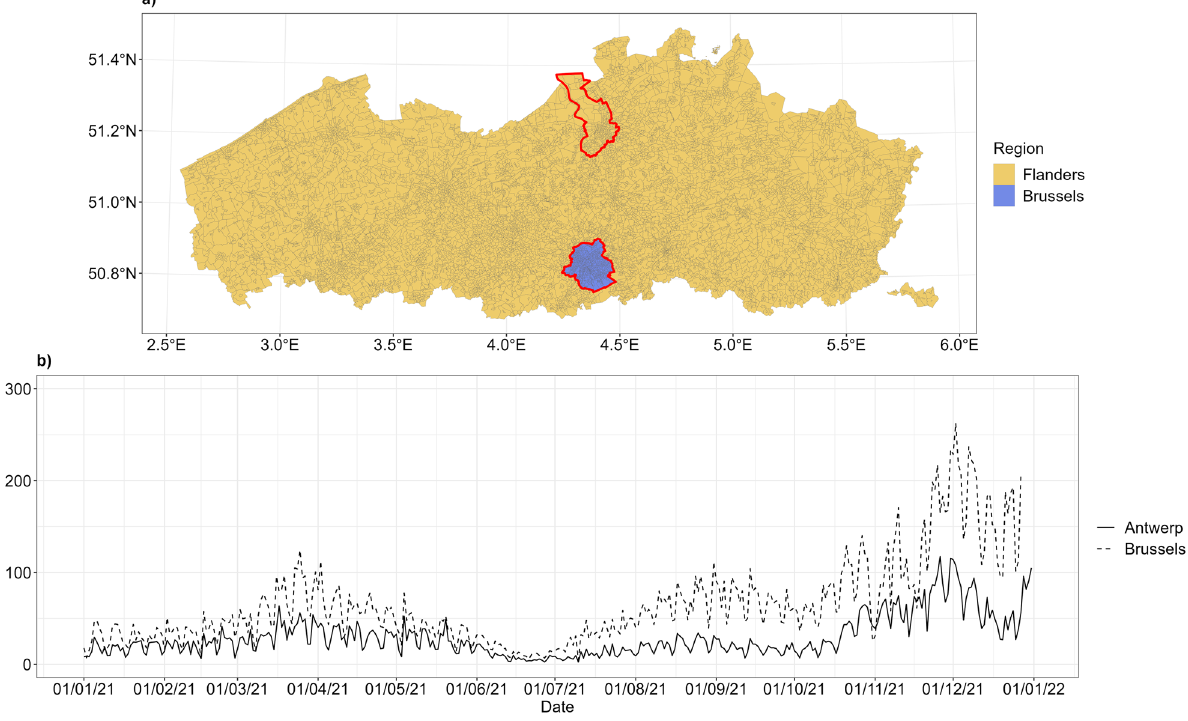
Figure 1. Statistical sectors in Flanders and Brussels Region. The location of selected study areas is marked by red line in a). Daily incidence rates per 100,000 inhabitants of these two areas are shown in b). The map is adapted from https:// statb el. fgov. be/ en/ open- data/ stati stical- secto rs- 2020 using R 4.2.1 (https:// CRAN.R- proje ct.